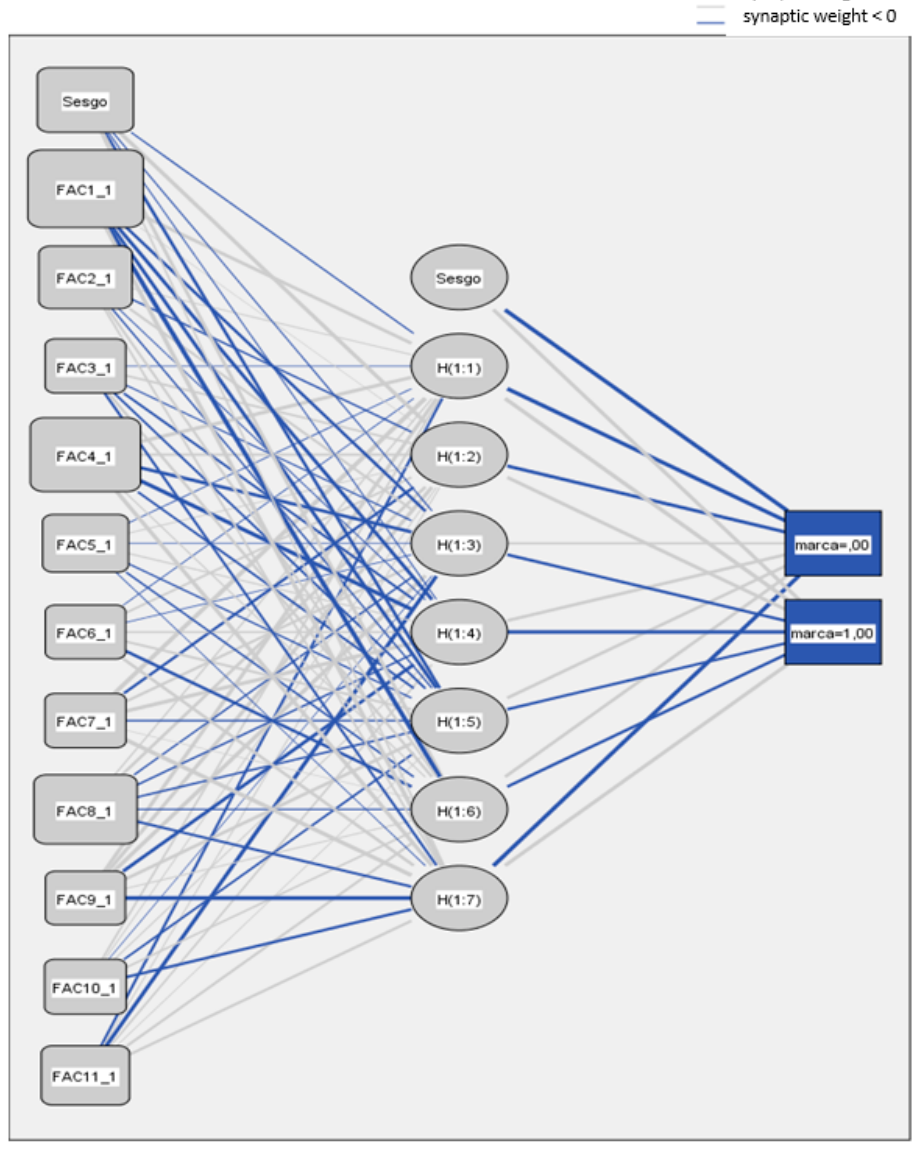
Figure 5. Neural network structure for the model estimation.